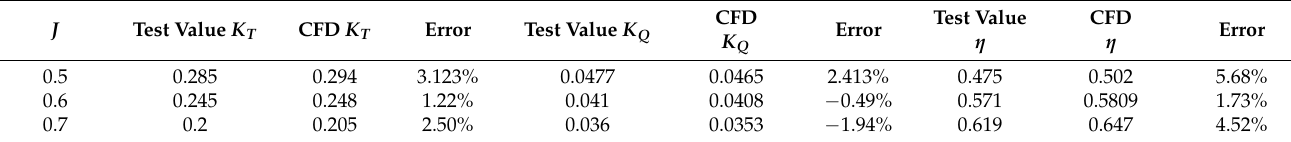
Table 4. Error comparison of propeller hydrodynamic results for different J